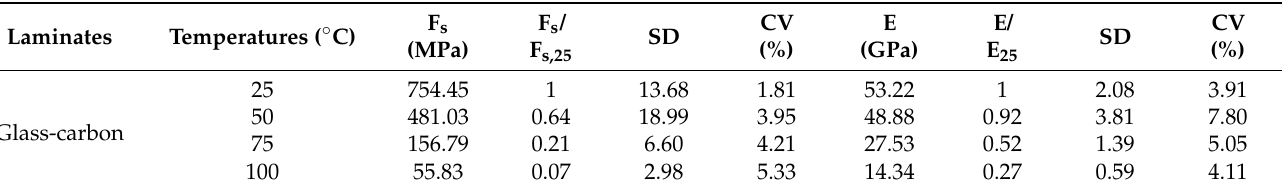
Table 5. Flexural strength (Fs) and modulus (E)properties of bidirectional glass–carbon laminates under different temperatures.